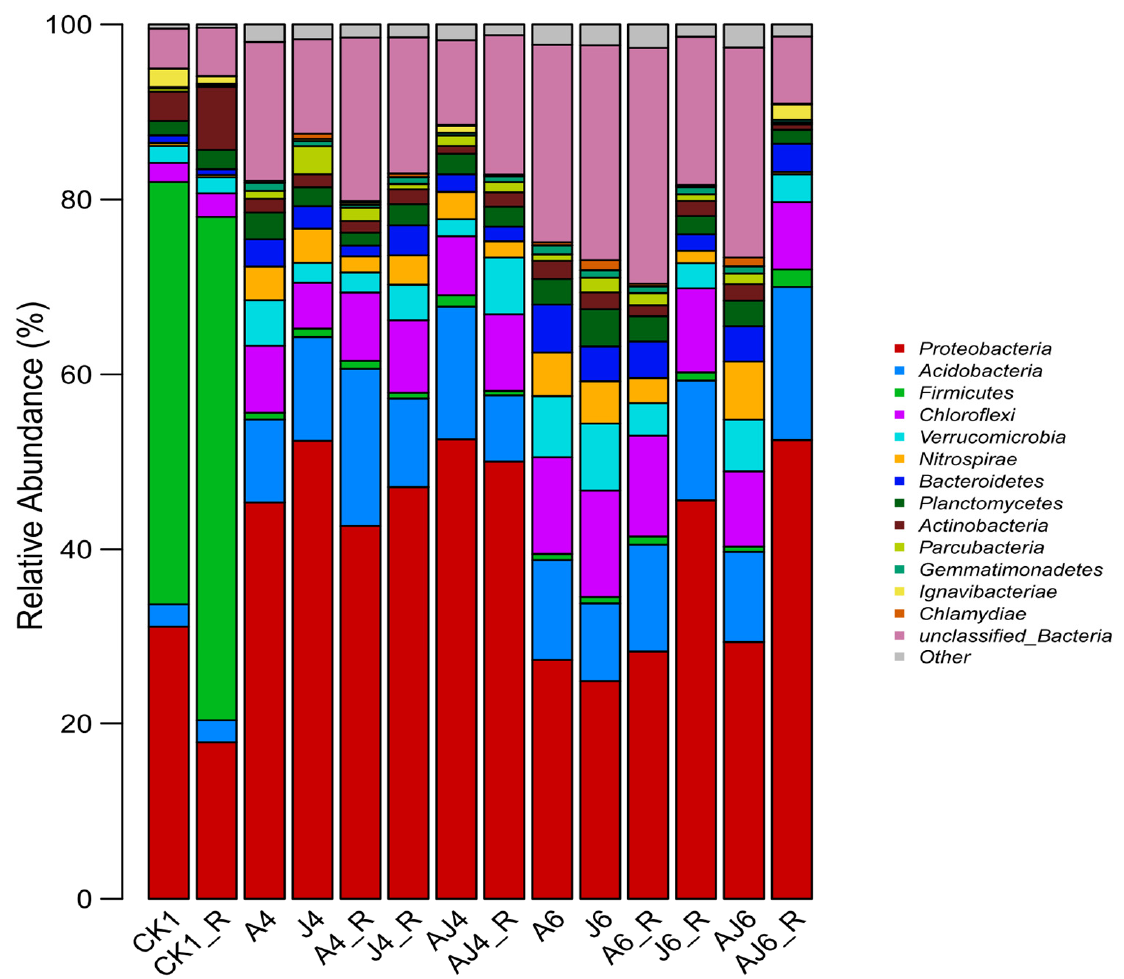
Figure 7. Relative abundance of microorganisms at the phylum level under different treatment conditions (only the top 10 species are shown, non-top-10 or non-detected species are indicated by Other).